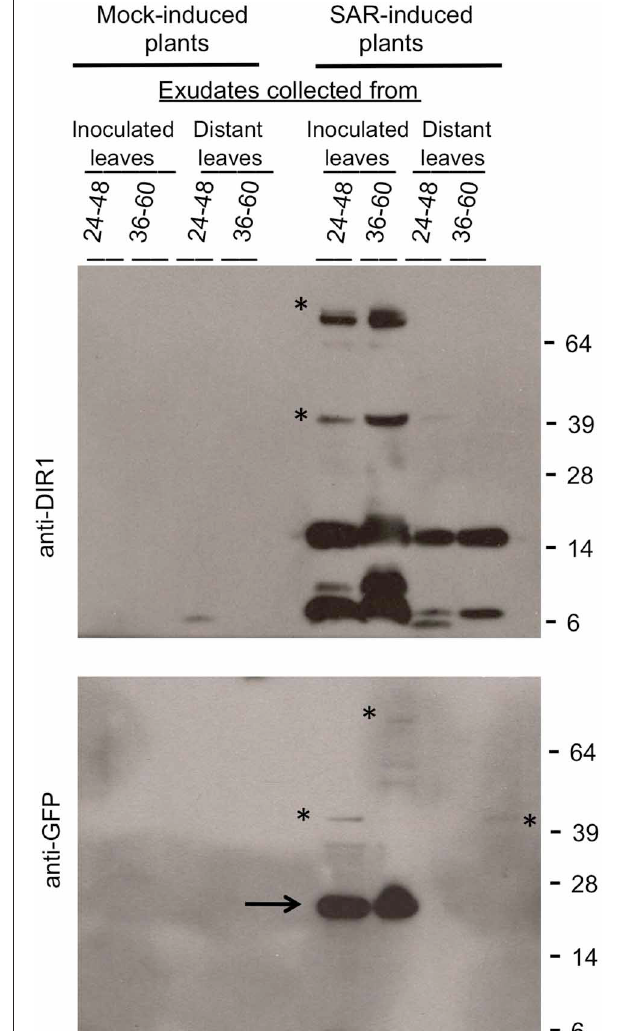
FIGURE 9 | Detection of DIR1-EGFP in SAR-induced and distant leaf petiole exudates. Petiole exudates were collected from the experiment shown in Figure 8 . DIR1-EGFP expression was induced in the T4 XVE:DIR1-EGFP-2-3/ dir1-1 line by estrogen infiltration, followed by mock- or SAR- induction ( Pst-avrRpt2 ) in these same leaves and collection of exudates from inoculated and distant leaves over 24–48hpi and 36–60hpi. Exudates were lyophilized and subjected to protein gel blot analysis with the DIR1 (top) or GFP antibodies (bottom). Protein molecular weight markers are indicated (64, 39, 28, 14, 6kDa). The asterisks indicate signals at ∼ 40kDa (DIR1-EGFP + DIR1) and at ∼ 66kDa (2 DIR1-EGFP). The arrow indicates a ∼ 26kDa EGFP band. This experiment was repeated four times with similar